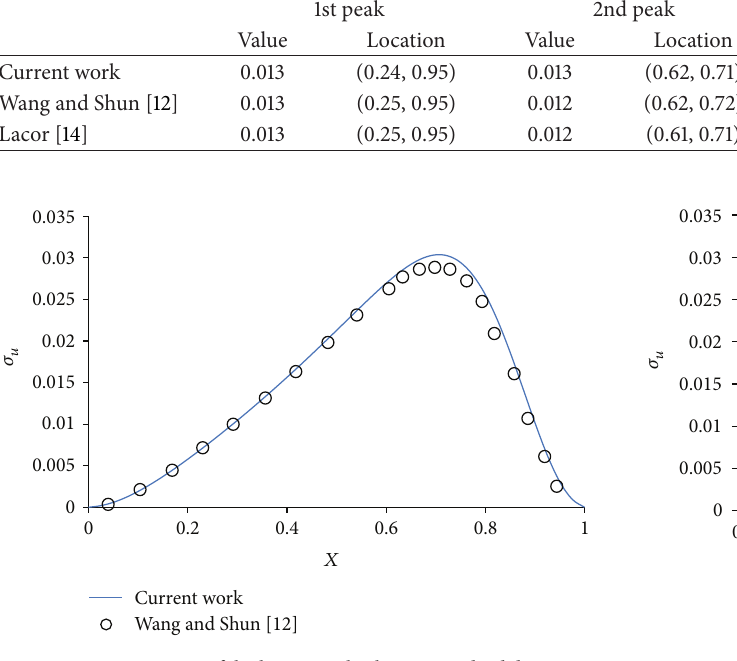
Figure13:Comparisonofthehorizontalvelocitystandarddeviation at the horizontal midline (𝑦 = 0.5) for random lid velocity with 10% standard deviation.